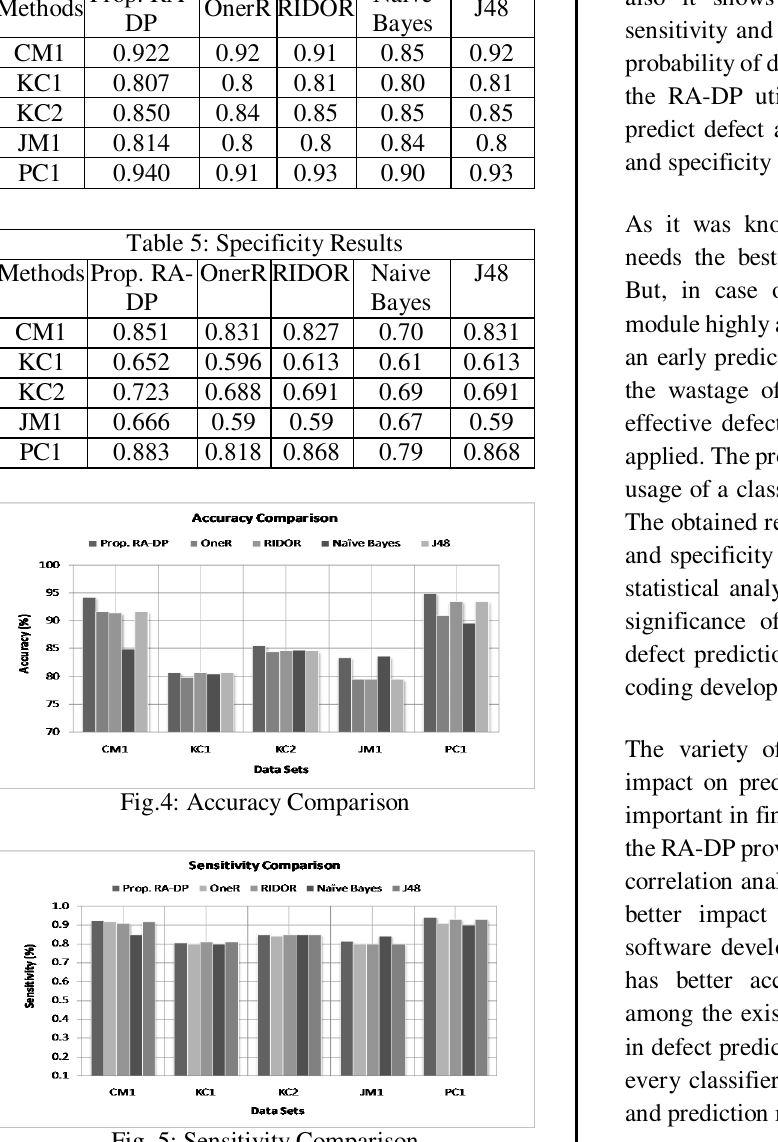
Fig. 5: Sensitivity Comparison